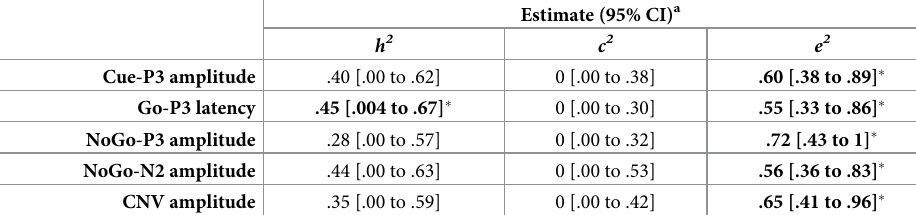
Table 4. Standardized estimates of genetic, shared and nonshared environmental contributions to the variance of ERPs (from the flanked CPT) in univariate twin analyses.